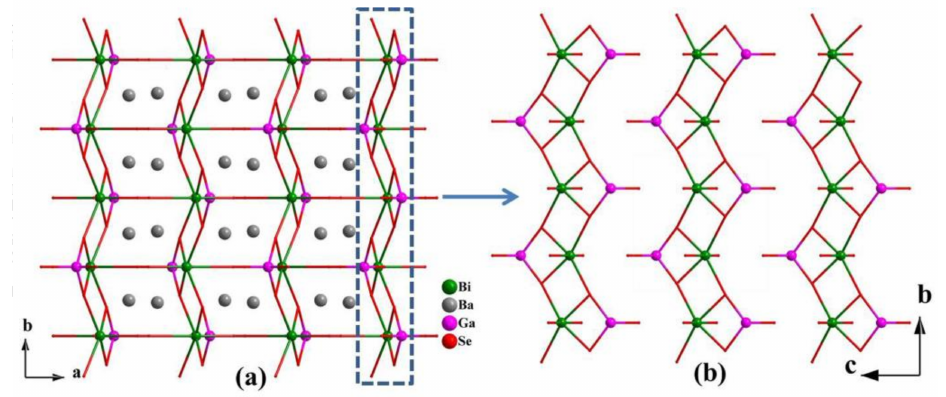
Figure 3. ( a ) View of the crystal structure of Ba 2 GaBiSe 5 along the c -axis; ( b ) isolated 1D